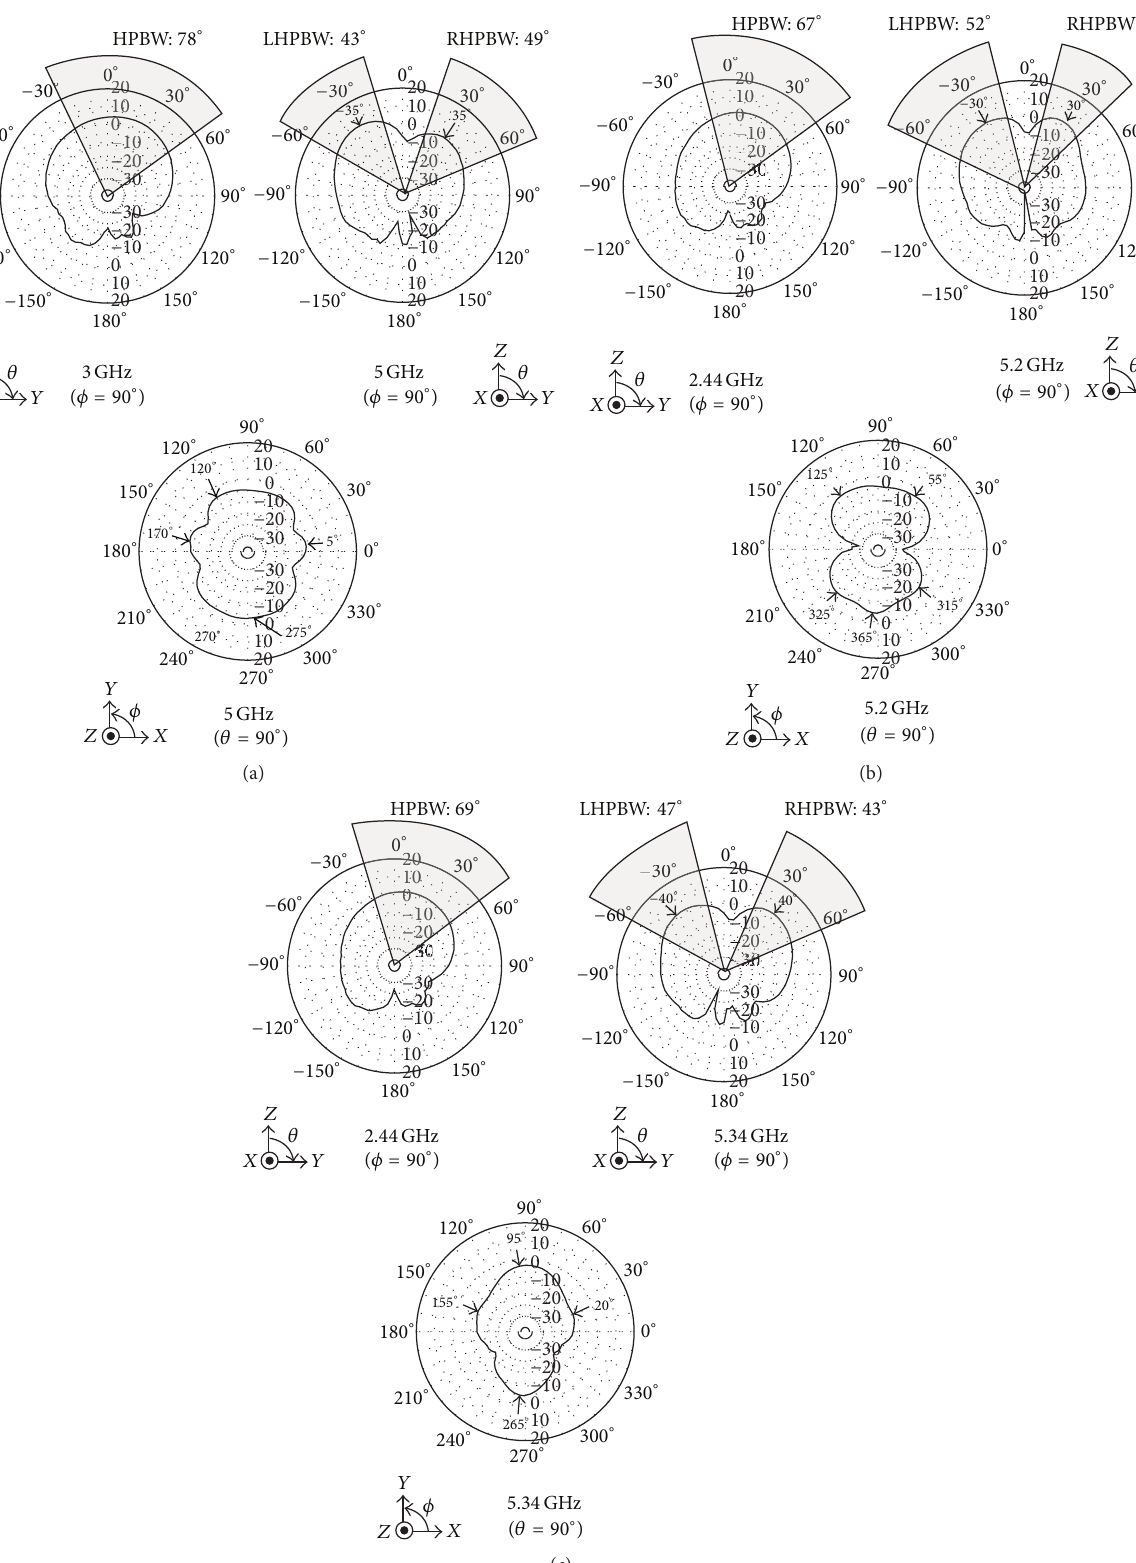
Figure 7: Measured 2D radiation patterns of the proposed antennas: (a) 1st order, (b) 2nd order, and (c) 3rd